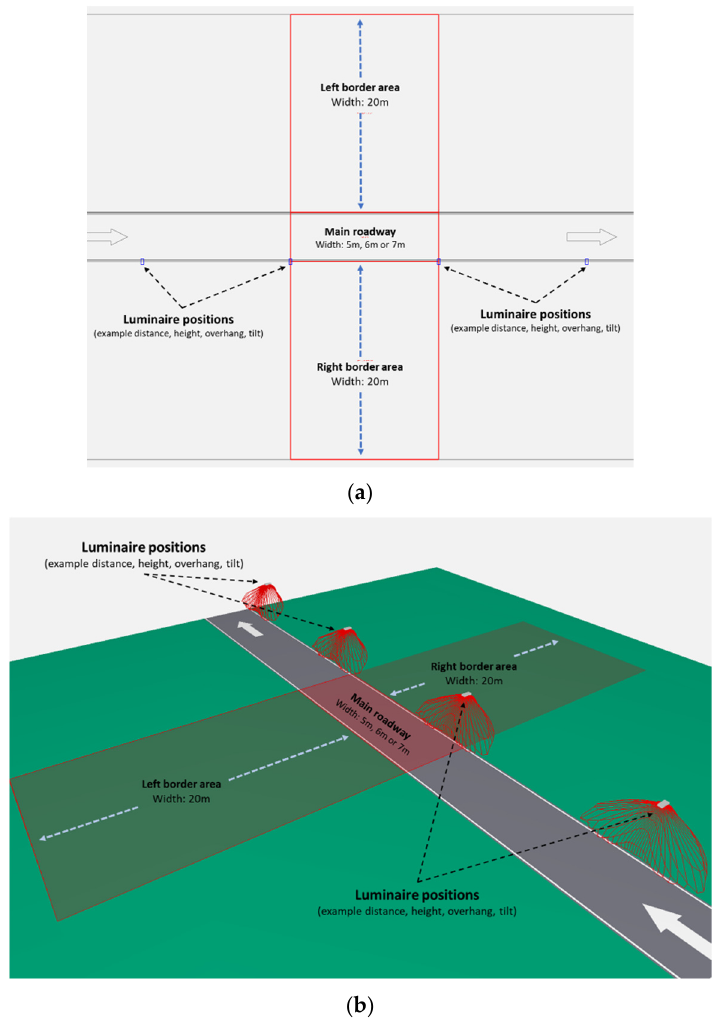
Figure 1. Overview of the road model setup in ReluxDesktop and used for the calculations. The specific arrangement shown (pole distance, height, overhang, tilt, road width) and the light distribution curves are indicative: ( a ) Layout of the road geometry and border areas; ( b ) 3D view of a typical calculation case.